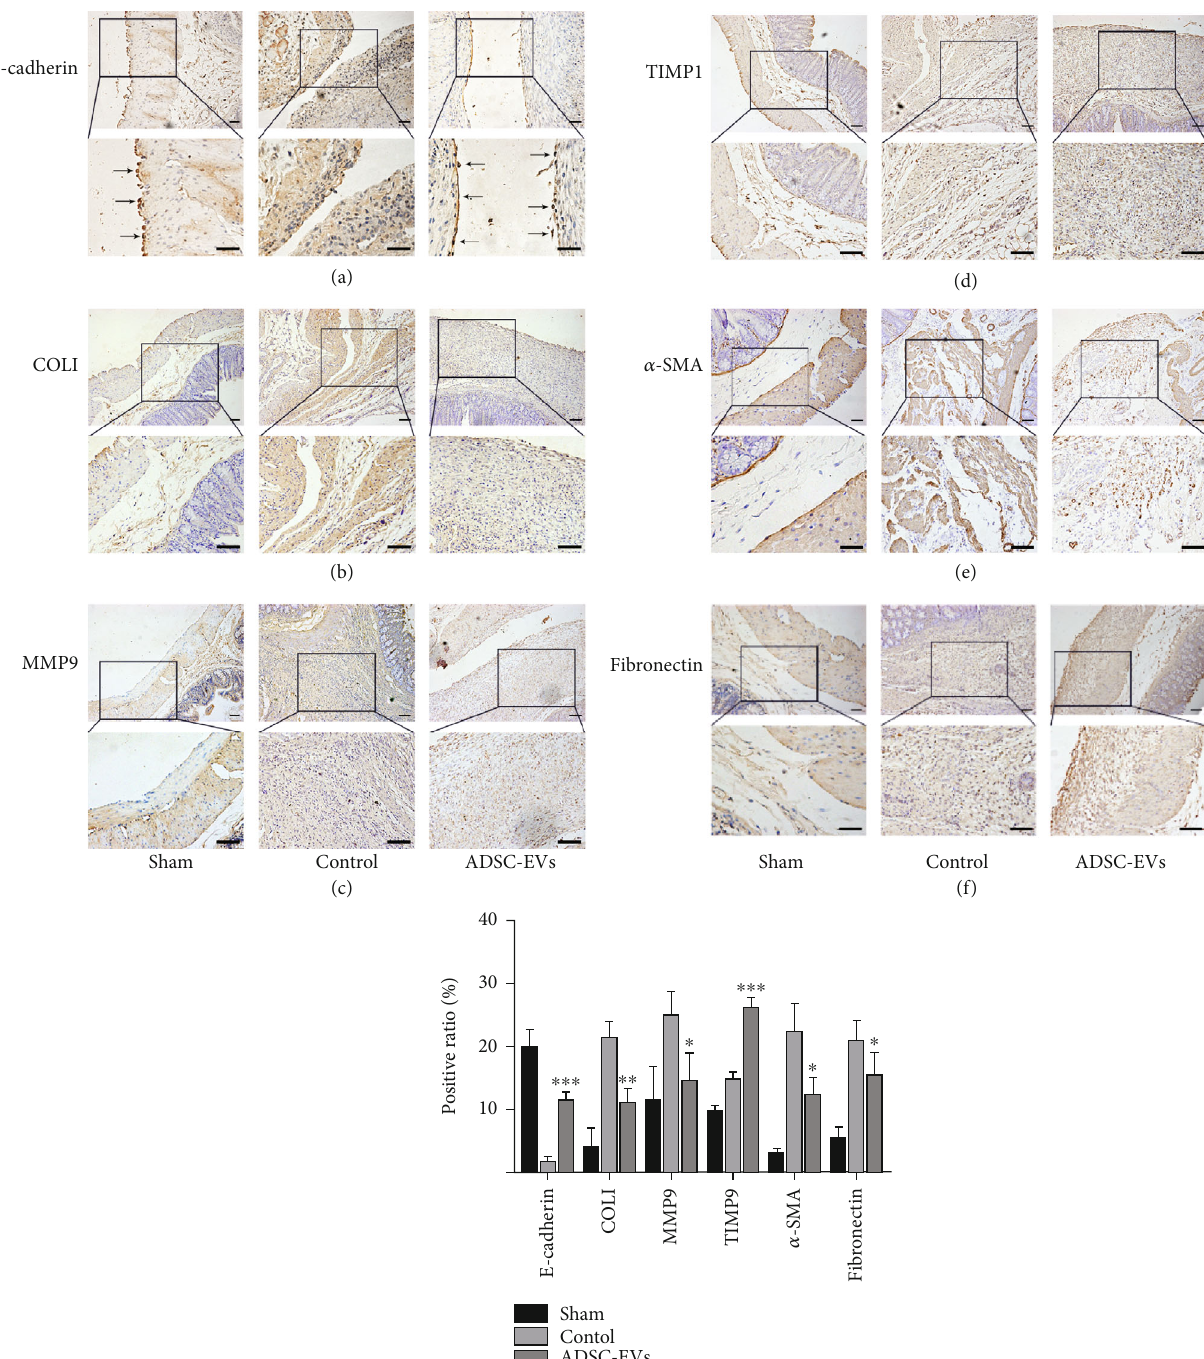
Figure 5: Impact of ADSC-EVs on peritoneal mesothelium cells and peritoneal matrix-related factors. (a) Immunohistochemical staining of E-cadherin in the injured areas peritoneum in each group of rats. RPMCs are shown by black arrow (100x in the upper plate, 200x in the below plate). (b – f) The expression of COL1, MMP-9, TIMP-1, α -SMA, and fi bronectin was evaluated at 15 days postsurgery by immunohistochemistry assay (100x in the upper plate, 200x in the below plate). (g) Quantitative analysis of peritoneal matrix-related factors at 15 days. Bars, 50 μ m. Data are represented as the mean ± SD . ∗ , vs. control; ∗ P < 0 : 05, ∗∗ P < 0 : 01, and ∗∗∗ P < 0 : 0001